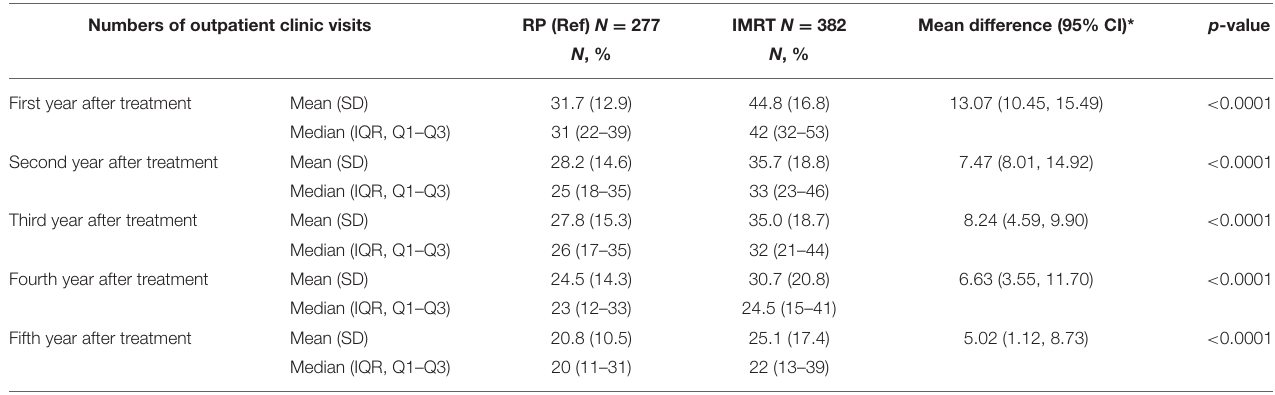
TABLE 1 | Generalized linear mixed model of numbers of urology outpatient clinic visits stratified by RP and